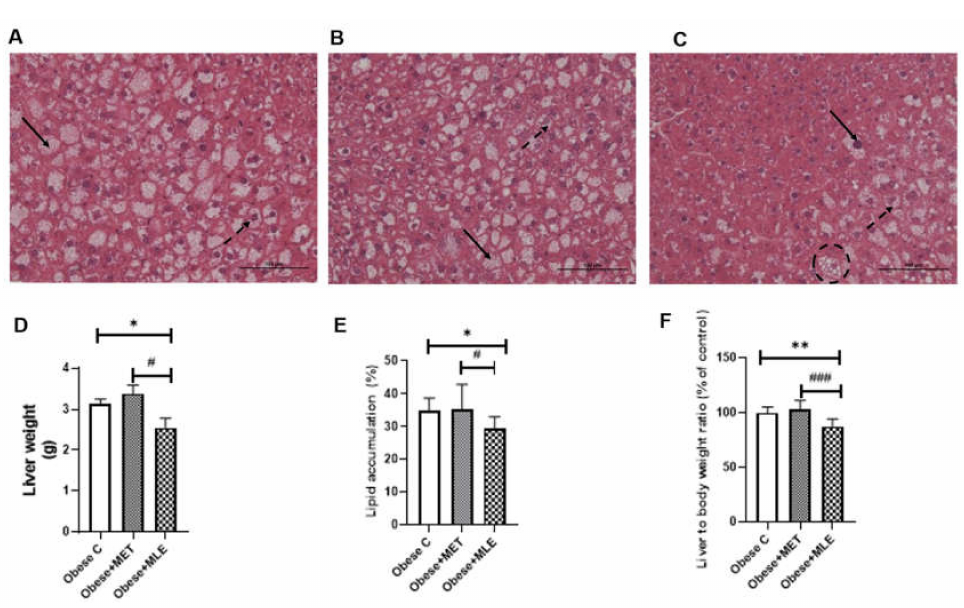
Figure 2. Hepatocellular steatosis, liver weight and percent lipid accumulation results. Representative photomicrographs of liver cross-sections of the obese C ( A ), obese + MET ( B ) and obese + MLE ( C ) mice. Histologically steatosis severity was classified by the number and distribution of hypertrophied hepatocytes (dotted circle) with either macrovesicular (bold arrows) or microvesicular (dotted arrows) steatosis. All photomicrographs were stained with H&E at 40 × magnification. Liver weight (D), % lipid accumulation (E), and liver to body weight ratio (F) results are represented as means ± SEM, with a sample size of 5/group (10 images per slide were taken). GraphPad Prism 9 was used to test for statistical significance at a p -value ≤ 0.05. Note: * p ≤ 0.05 and ** p ≤ 001 vs. obese C, # p ≤ 0.05 and ### p ≤ 0.0001 vs. obese +